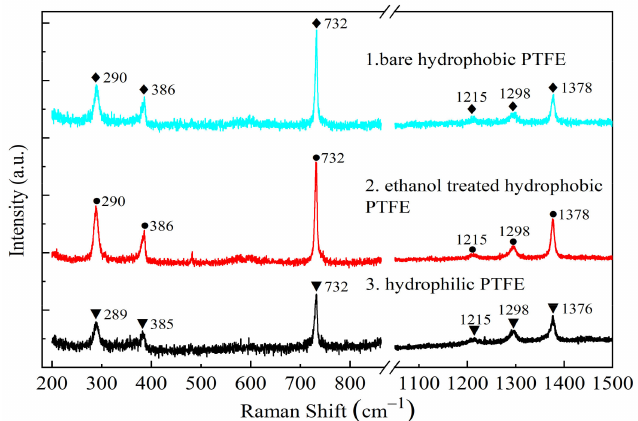
Figure 5. Raman spectrums of three kinds of PTFE: 1 . bare hydrophilic PTFE, 2 . ethanol-treated hydrophobic PTFE, 3 . hydrophobic PTFE.